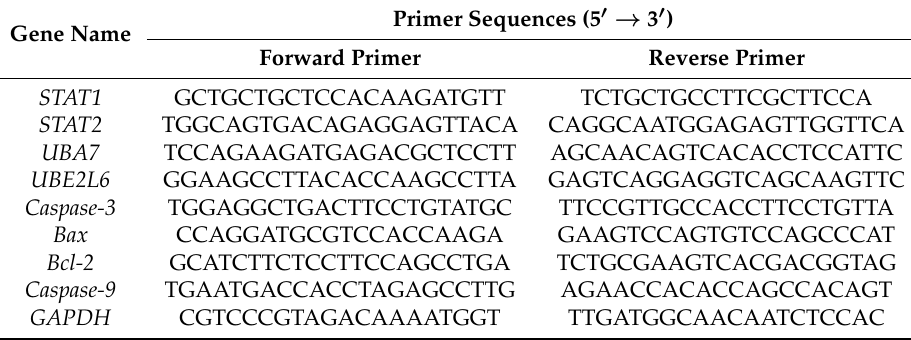
Table 1. Primers of the genes in q-PCR